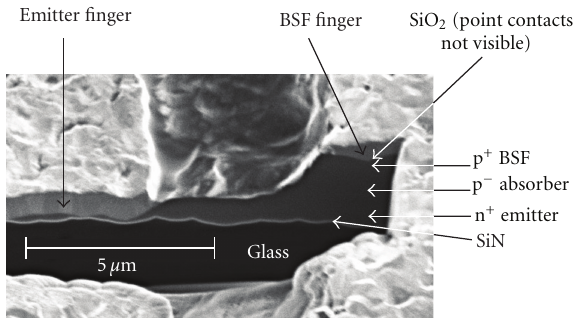
Figure 2: A focused-ion beam (FIB) image of the sidewall cross- section located at the emitter finger-BSF finger interface. A trench has been etched into the cell, and the sample tilted 45 ◦ to view the